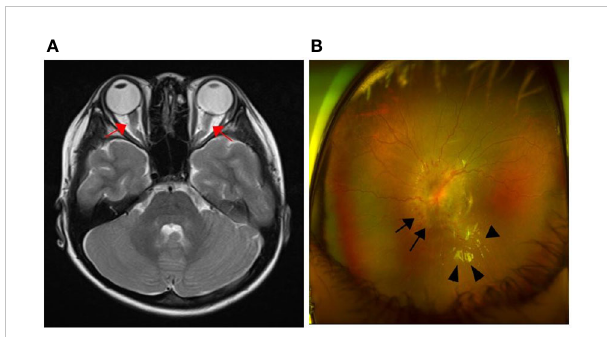
FIGURE 1 Brain MRI and fundoscopic fi ndings at the time of visual disturbance onset. (A) Axial T2-weighted image showed diffuse swelling of both optic nerves (arrow); (B) Optic disc edema (arrow) and macular star